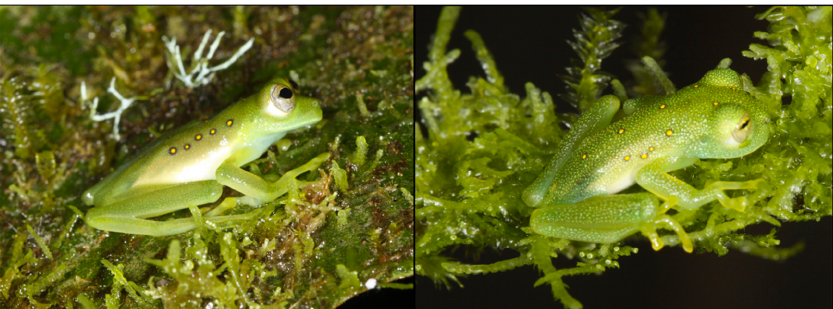
Figure 165. Nymphargus lindae sp. nov. in life. Left : Adult female, paratype, QCAZ 41597. Right : Male, also part of the type series. Photos taken at the type locality by Juan M. Guayasamin.